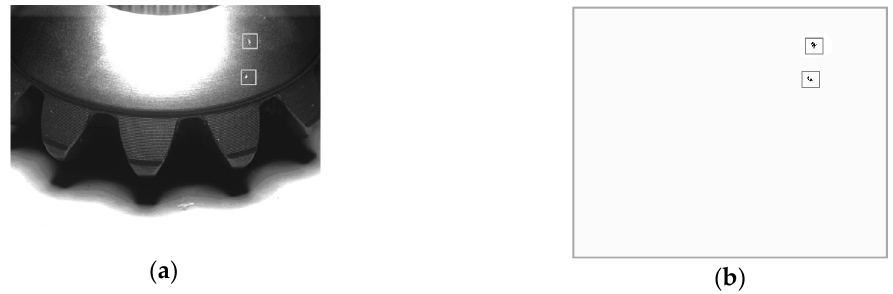
Figure 21. ( a ) A lateral image of the sphere surface; ( b ) Inspection result of Figure 21a.